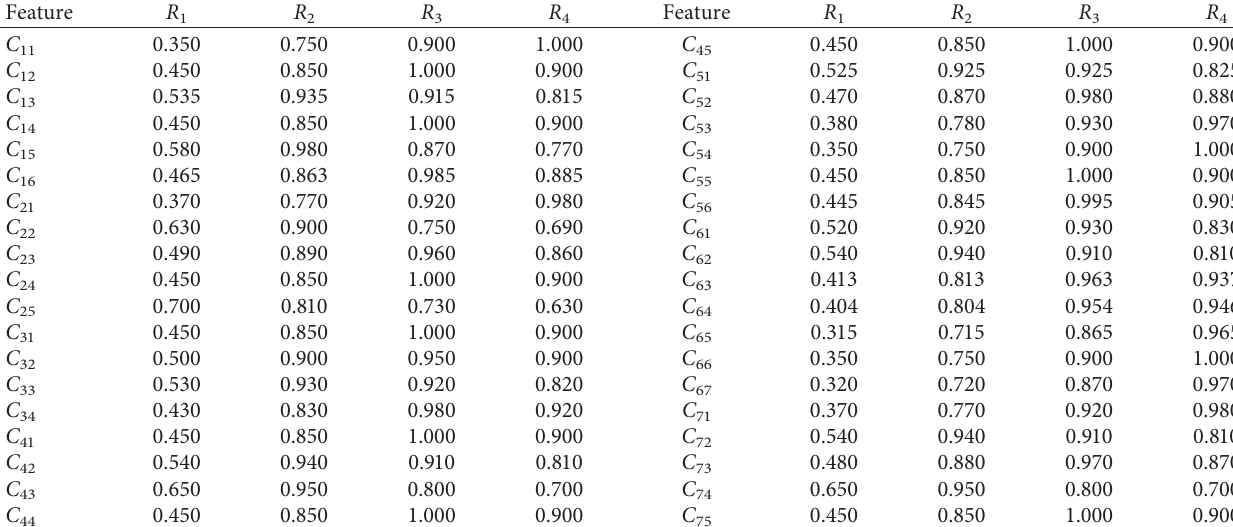
Table 5: Results on fuzzy